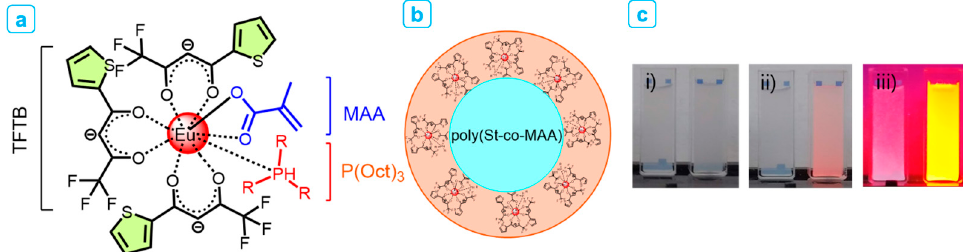
Figure 1. Schematic representation of ( a ) chemical structure of β -diketonate Eu 3+ complexes of Eu(TFTB) 2 (MAA)P(Oct) 3 and ( b ) core–shell structure of Eu(TFTB) 2 (MAA)P(Oct) 3 @poly(St- co -MAA). ( c ) photograph images of poly(St- co -MAA) (left) and Eu(TFTB) 2 (MAA)P(Oct) 3 @poly(St- co -MAA) (right) dispersed in water were taken under (i) daylight, (ii) day and UV light ( λ ex at 365 nm) and (iii) UV light.